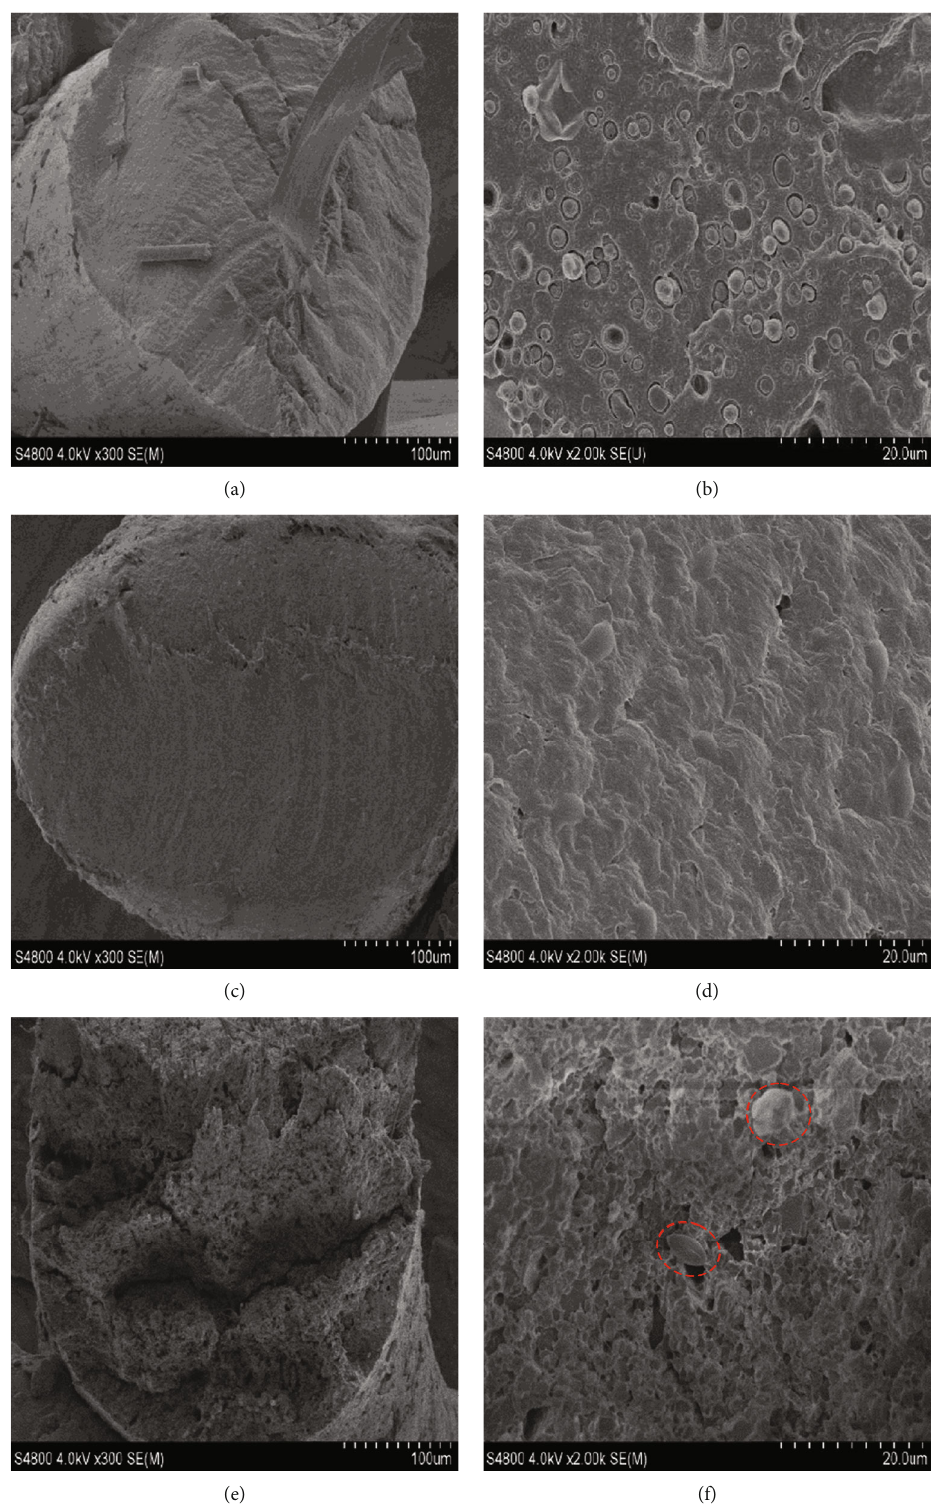
Figure 2: SEM images of starch-based composite fi bers. (a) STR/HDPE fi ber without adding MA at 300x. (b) STR/HDPE fi ber without adding MA at 2000x. (c) STR-50 at 300x. (d) STR-50 at 2000x. (e) STR-90 at 300x. (f) STR-90 at